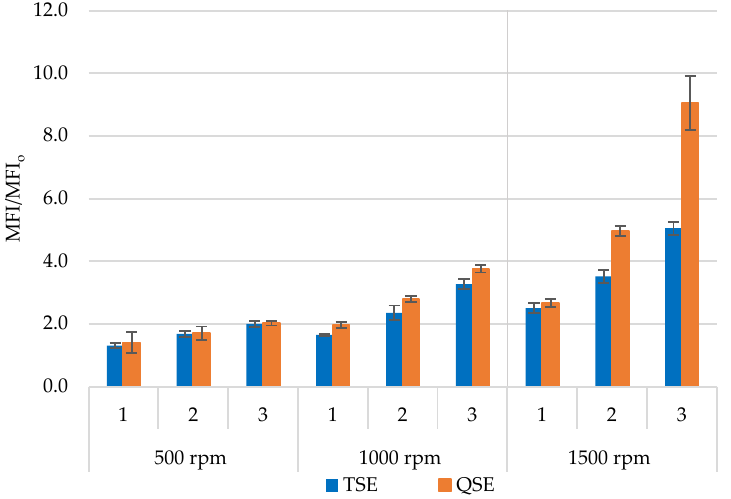
Figure 3. Melt flow index ratio (MFI/MFI o ) for polypropylene reprocessed using the TSE and the QSE at three screw speeds and for three reprocessing cycles.